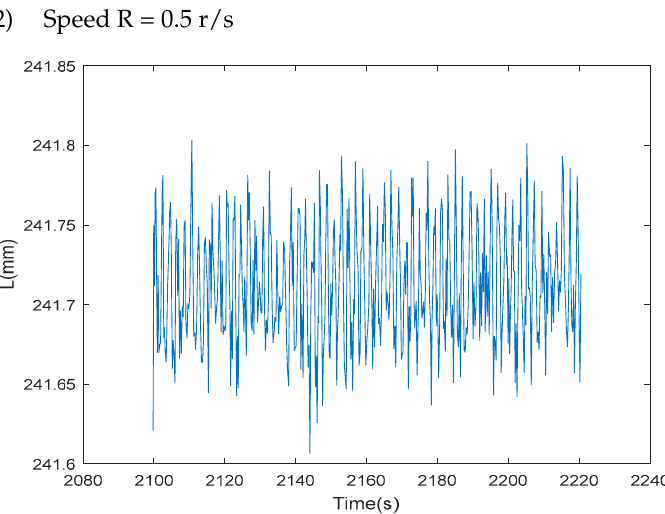
Figure 12. Measurement results of the distance between two targets at 0.5 r/s.